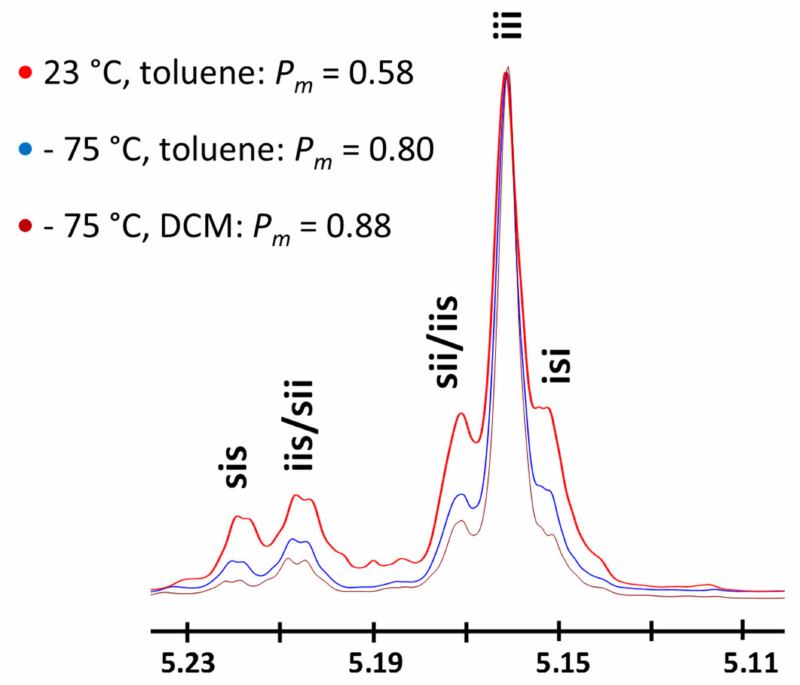
Figure 2. Methine region of homonuclear decoupled 1 H-NMR spectra of poly( rac -LA) obtained at di ff erent polymerization temperatures and solvents using TBD as a catalyst ( X -axis in ppm). Peak attributions from